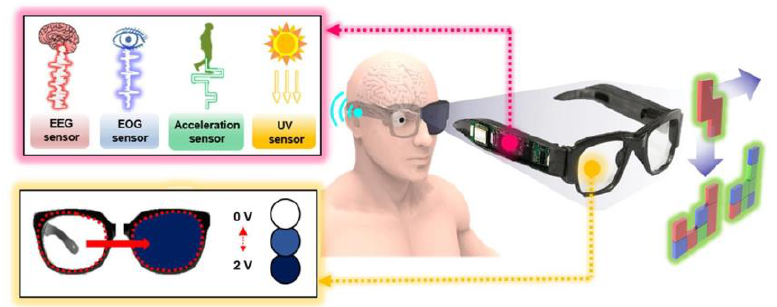
Figure 14. Working diagram of Smart Electronic Eyeglasses [96].